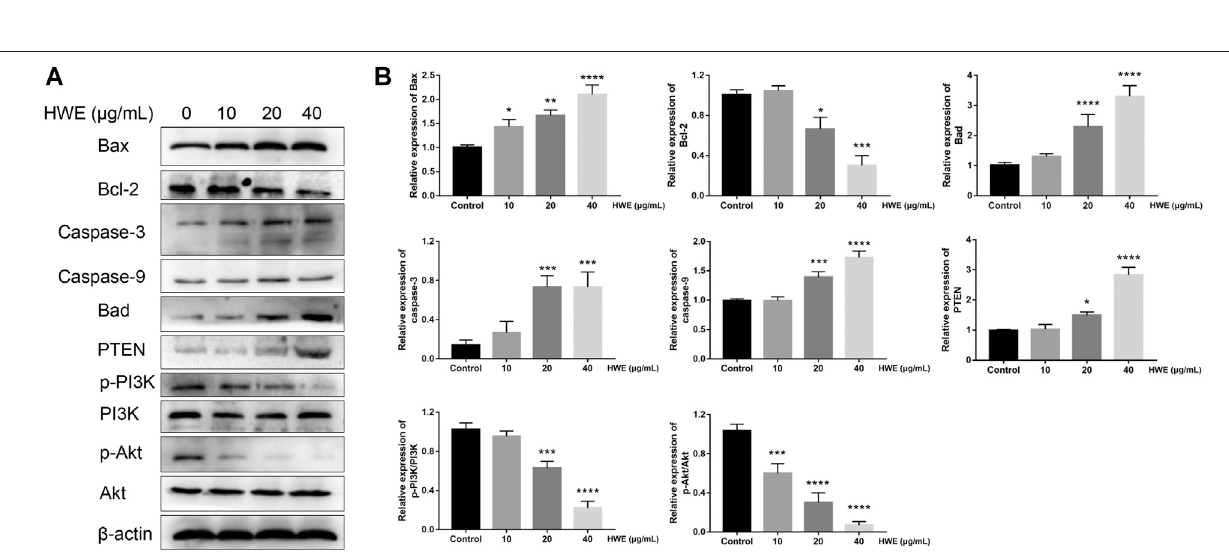
Frontiers in Pharmacology |